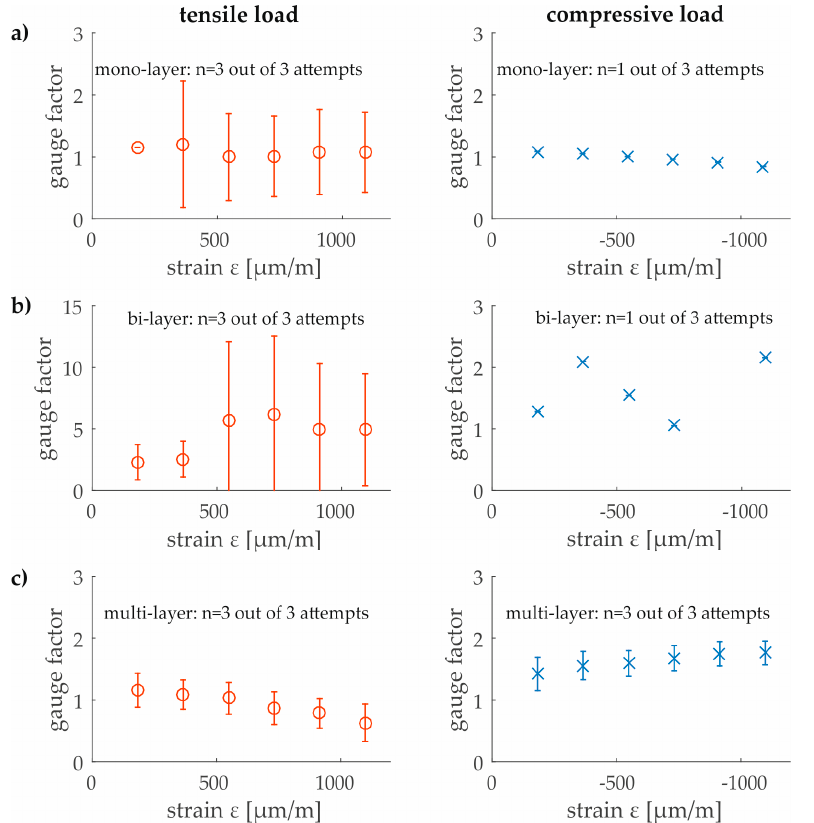
Figure 7. Gauge factors (including number of measurements, the mean and the standard deviation) of mono- ( a ), bi- ( b ) and multi-layer ( c ) CVD graphene for tensile and compressive loads on the cantilever beam.